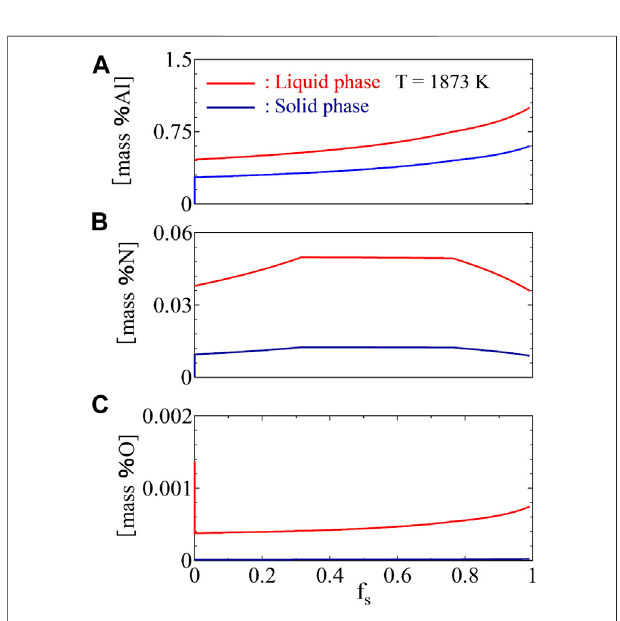
FIGURE 9 | Variations of concentrations of Al (A) , N (B) , and O (C) in liquid phase during the solidi fi cation